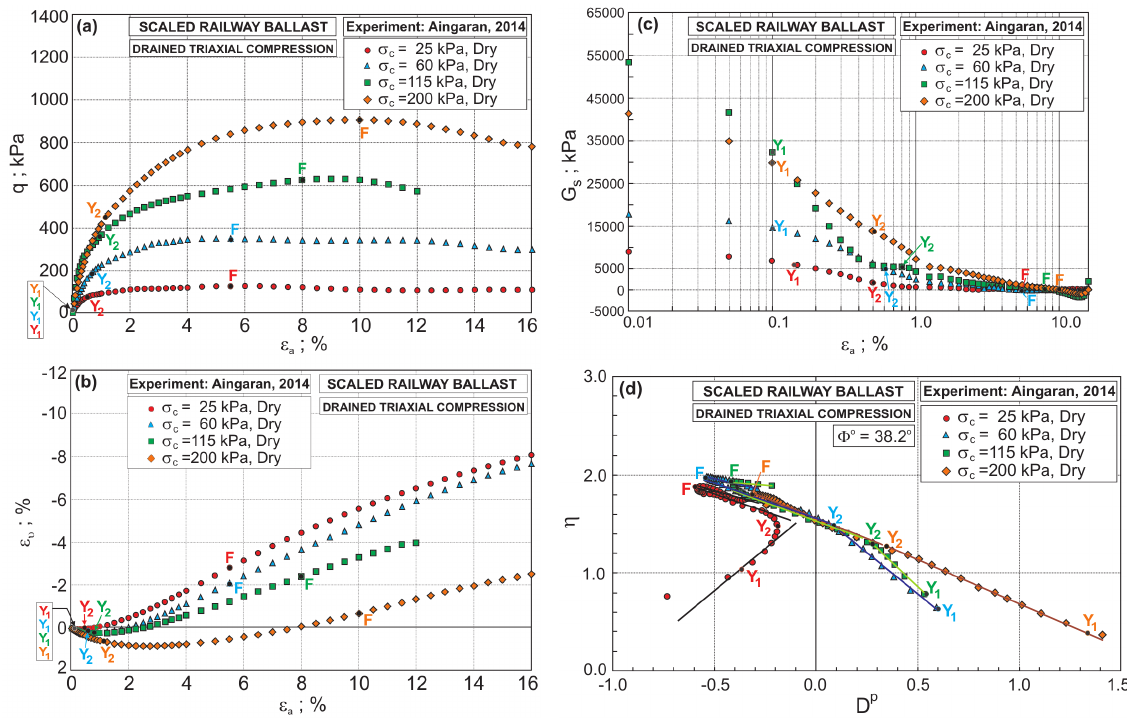
Figure 2 : Relationships for dry scaled ballast: (a) q – e